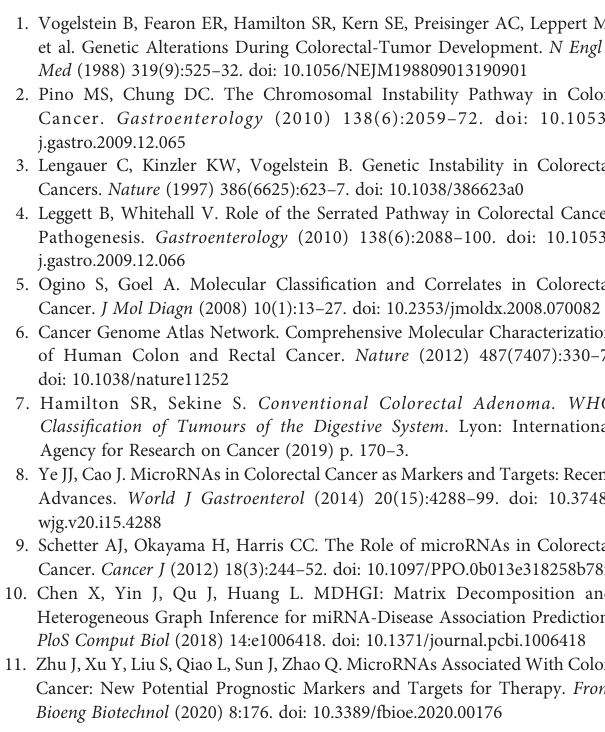
Supplementary Figure 2 | (A) . Histological feature (HE). (B) . Isolated glands under a dissecting microscope. (C) . Hematoxylin – eosin staining of isolated crypts. (D) . Normal gland (BAT25). (E) . Tumor gland (BAT25). (F) . Normal gland (BAT26). (G) . Tumor gland (BAT26). Supplementary Figure 3 | Candidate connection of paired miRNAs/mRNAs with reciprocal expression in adenoma (A) , IMC (B) , and CRC with the MSS phenotype (C) (type A). Supplementary Figure 4 | Signi fi cant miRNA/mRNA pairs with inverse relationships in adenoma (A) components (A) , IMC (B) , and CRC with the MSS phenotype (C) . Supplementary Figure 5 | miRNA/mRNA pairs with inverse relationships based on the adenoma – carcinoma sequence within the same tumor. (A) Adenoma and (B) IMC